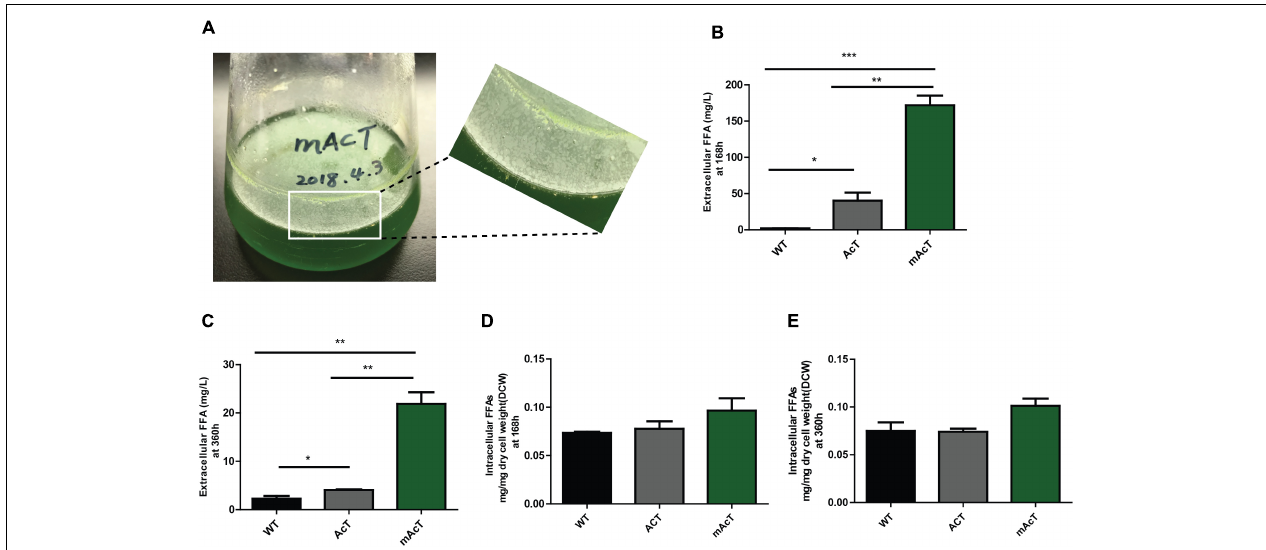
FIGURE 2 | Production and secretion of FFAs. Cultures were grown at 30 ◦ C in a BG-11 medium under continuous illumination of 25 µ mol photons m − 2 s − 1 light. (A) Droplets of FFAs appeared on the culture medium of mAcT after 168 h. GC-MS-based analysis of (B) extracellular FFAs (FFAs) at 168 h, (C) extracellular FFAs (FFAs) at 360 h, (D) intracellular FFAs at 168h and (E) intracellular FFAs at 360 h from the culture of WT, AcT and mAcT set in a 250 mL flask. Data shown in (B–E) are the mean ± SE from biological triplicates, and ‘ ∗ ’ represents statistical significance as indicated by Student’s t -test with a maximum p -value of < 0.05.